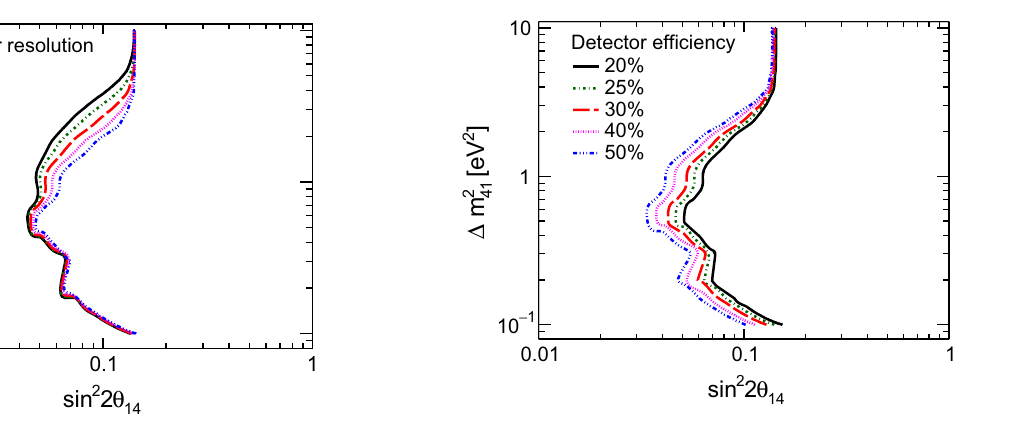
Fig. 4 The 90% C.L. exclusion limits in the Δ m 2 where sin 2 2 θ 14 = 4 U 2 at different PS detector resolution